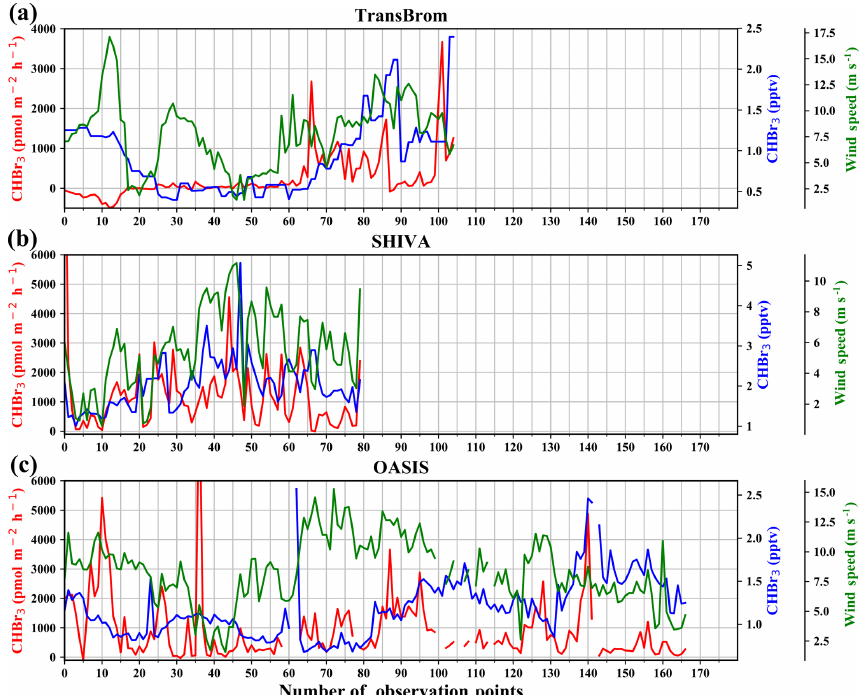
Figure 8. Surface wind speeds (green), CHBr 3 air–sea flux (red), and atmospheric mixing ratios of CHBr 3 near the surface (blue) observed during the TransBrom, SHIVA, and OASIS